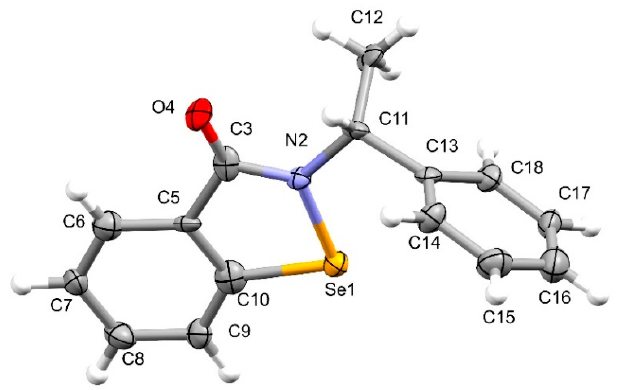
Figure 3. Molecule 1 of 24a with atomic displacement parameters plotted at a 50% probability level.